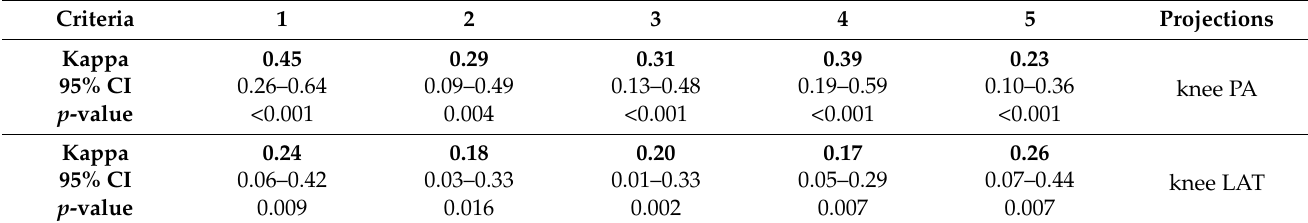
Table 7. Fleiss’ kappa assessing interobserver agreement with an asymptotic 95% CI for each criterion in knee PA/LAT